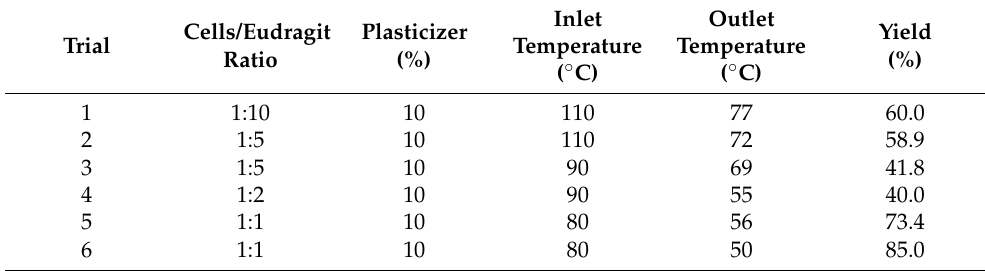
Table 2. Results of yield for each attempt of coating.